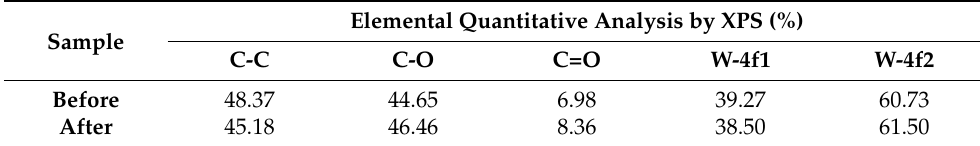
Table 1. Elemental analysis of A-CNF/PTA50% before and after the catalytic process.